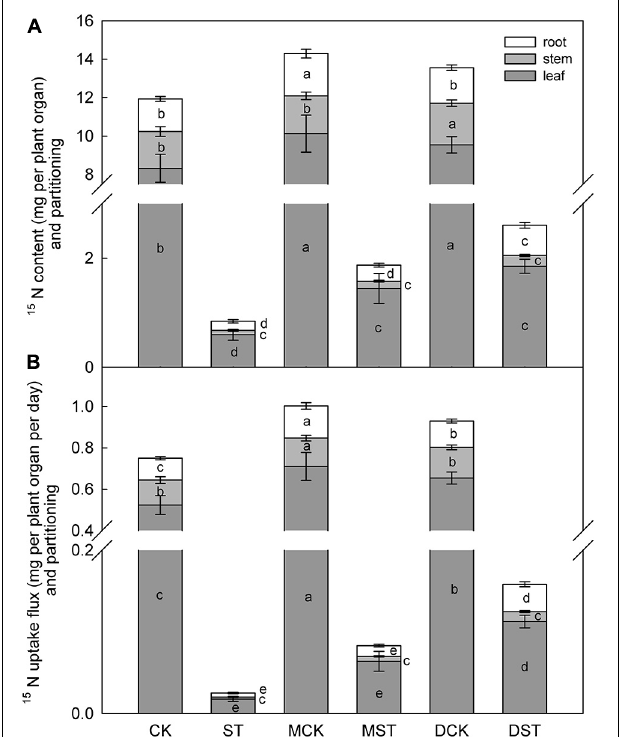
FIGURE 3 | Effect of melatonin and dopamine on 15 N content (A) and uptake flux (B) of Malus hupehensis plants grown 20 days under different N levels and material treatments. Data are means ± SD ( n = 10). Values not followed by same letter denote significant differences by Tukey’s multiple range tests ( P < 0.05). CK, 2 mM K 15 NO 3 solution; ST, 0.1 mM K 15 NO 3 solution; MCK, 2 mM K 15 NO 3 solution with 0.1 µ mol/L melatonin; MST, 0.1 mM K 15 NO 3 solution with 0.1 µ mol/L melatonin; DCK, 2 mM K 15 NO 3 solution with 100 µ mol/L dopamine; DST, 0.1 mM K 15 NO 3 solution with 100 µ mol/L